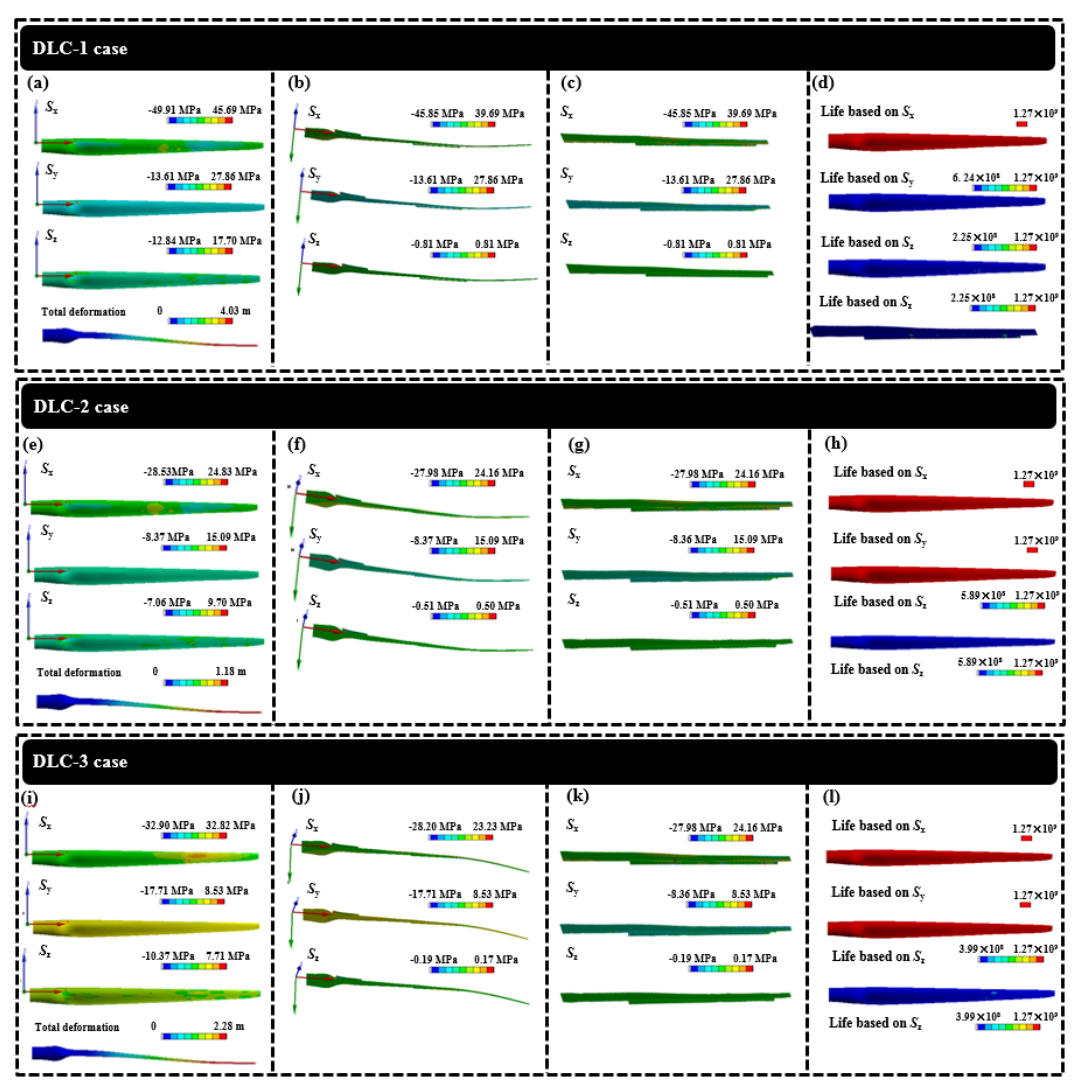
Figure 7. Validation of performance indexes for the second generation wind turbine blade in the DLC-1, DLC-2 and DLC-3 cases. ( a , e , i ) Stress and deformation contours of whole turbine blade. ( b , f , j ) Stress contours of internal structure. ( c , g , k ) Stress contours of localized regions of internal structure. ( d , h , l ) Fatigue life contours of whole turbine blade.